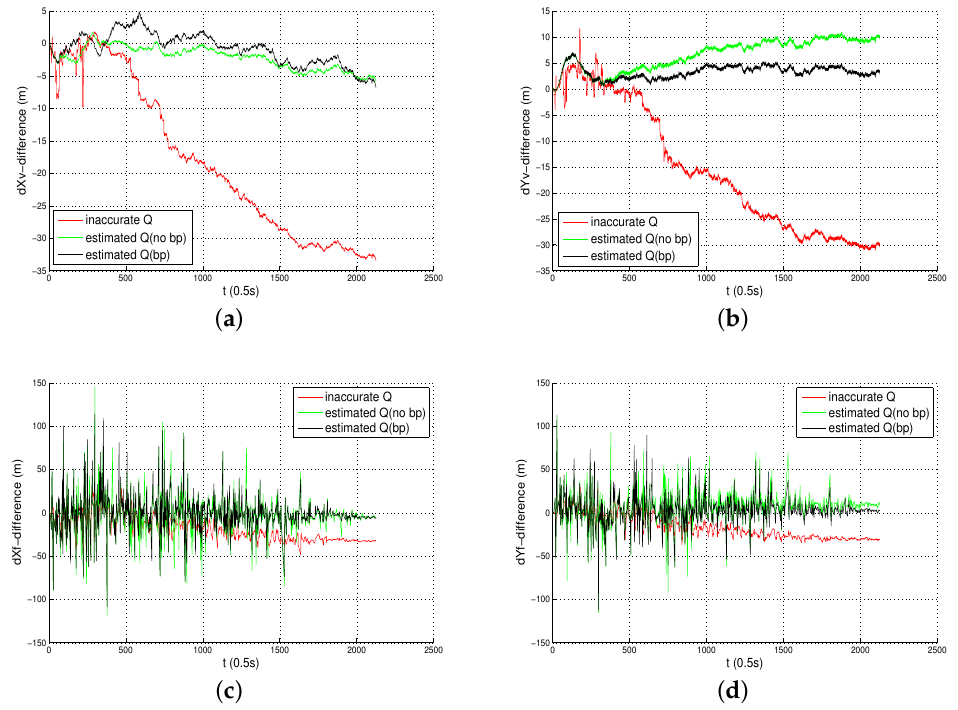
Figure 15. The positioning error of AUV and MRS, in which ( a ) illustrates the horizontal direction of the positioning error components of AUV in global frame; ( b ) illustrates the vertical direction of the positioning error components of AUV in global frame; ( c ) illustrates the horizontal direction of the positioning error components of MRS in global frame; ( d ) illustrates the vertical direction of the positioning error components of MRS in global frame.